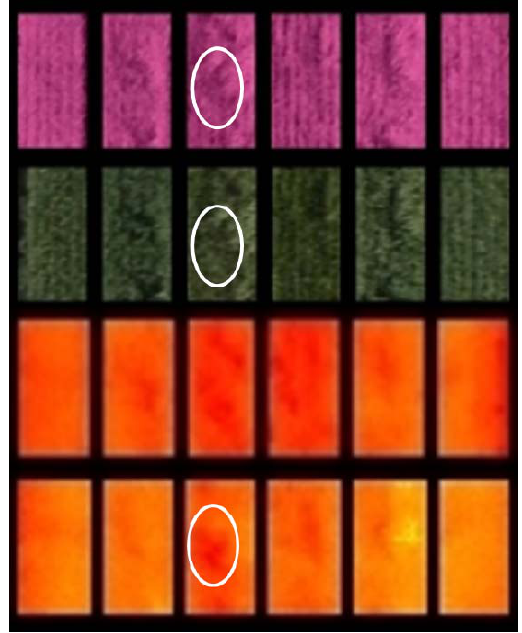
Figure 9. Comparison of trimmed images for six adjacent plots of a wheat trial from flights made on November 14, 2011, from 60 m of elevation at about one week after flowering time. The top three images (NIR (red-edge) filtered, RGB and false-colour thermal (yellow = cooler; red = hotter)) were taken at 11:00 h, while the bottom thermal image was taken at 15:05 h. The white ovals indicate a lodged area of the third plot (lodging is also evident in Plots 2, 4 and